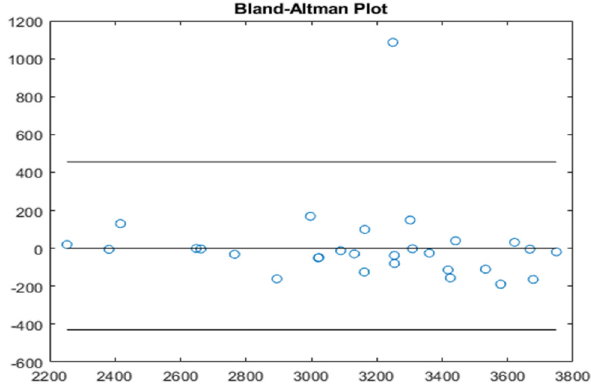
Figure 21: Bland – Altman scatter plot for the density feature.